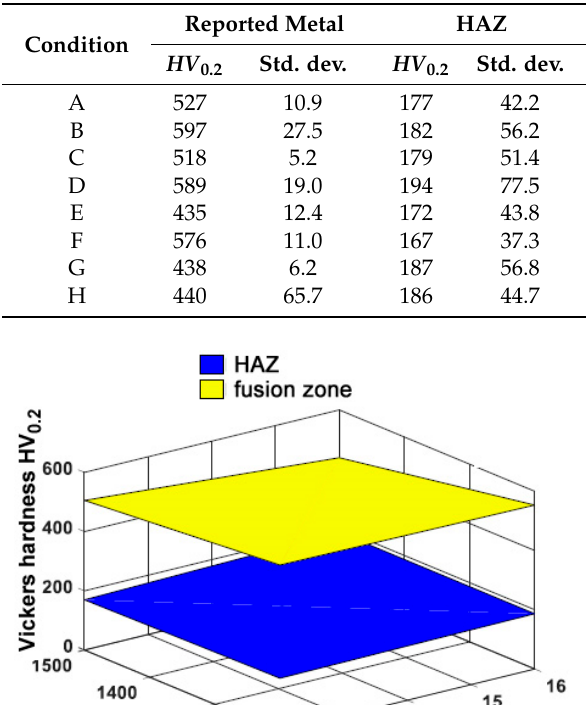
Figure 14. Example of the trend of Vickers microhardness under condition F; edge deposition. Table 11. Average Vickers micro-hardness as a function of the processing conditions; edge deposition.